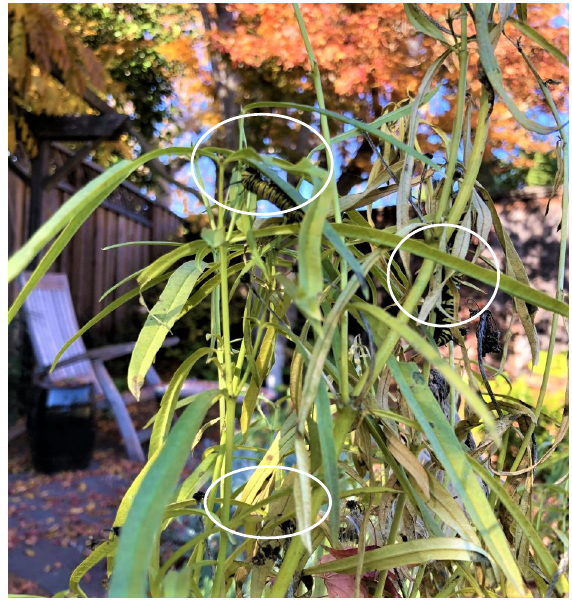
Figure 9. Native milkweed, Asclepias fascicularis, and late instar monarch larvae (circled) in a Palo Alto backyard on 3 December 2020 (Photo: John Tang).